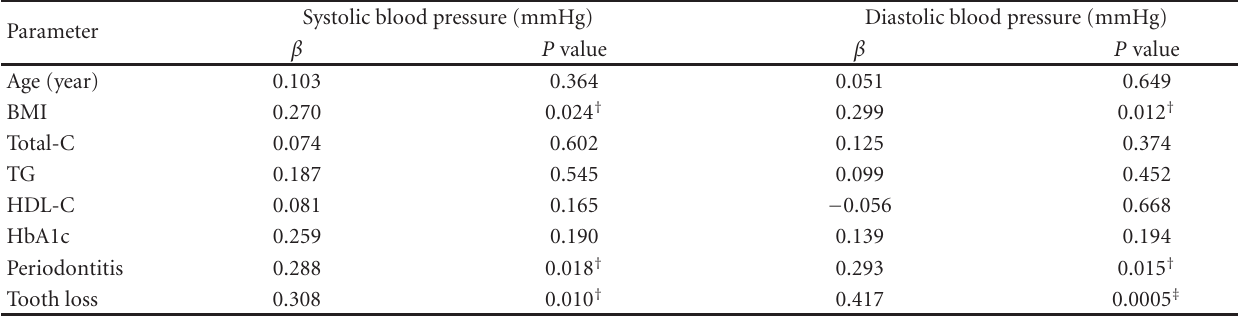
Table 2: Multiple-regression analysis of BP, periodontitis, tooth loss, and traditional risk factors possibly related to hypertension in middle- aged women.